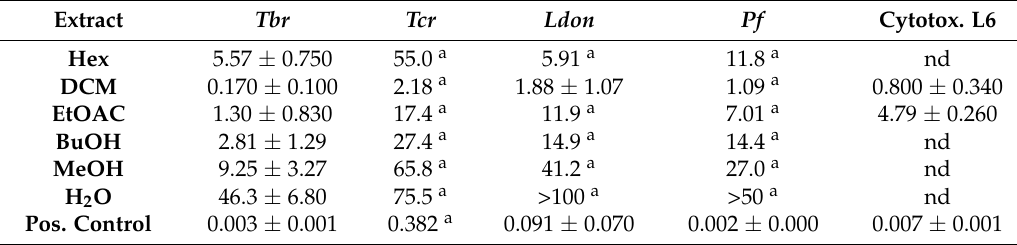
Table 1. In vitro antiprotozoal and cytotoxic activity (IC 50 values in µ g/mL) of crude extracts from V. lasiopus . Selectivity indices (SI) represent the ratio of cytotoxic over antiprotozoal IC 50 values. Data are means of two independent determinations ± standard deviation.